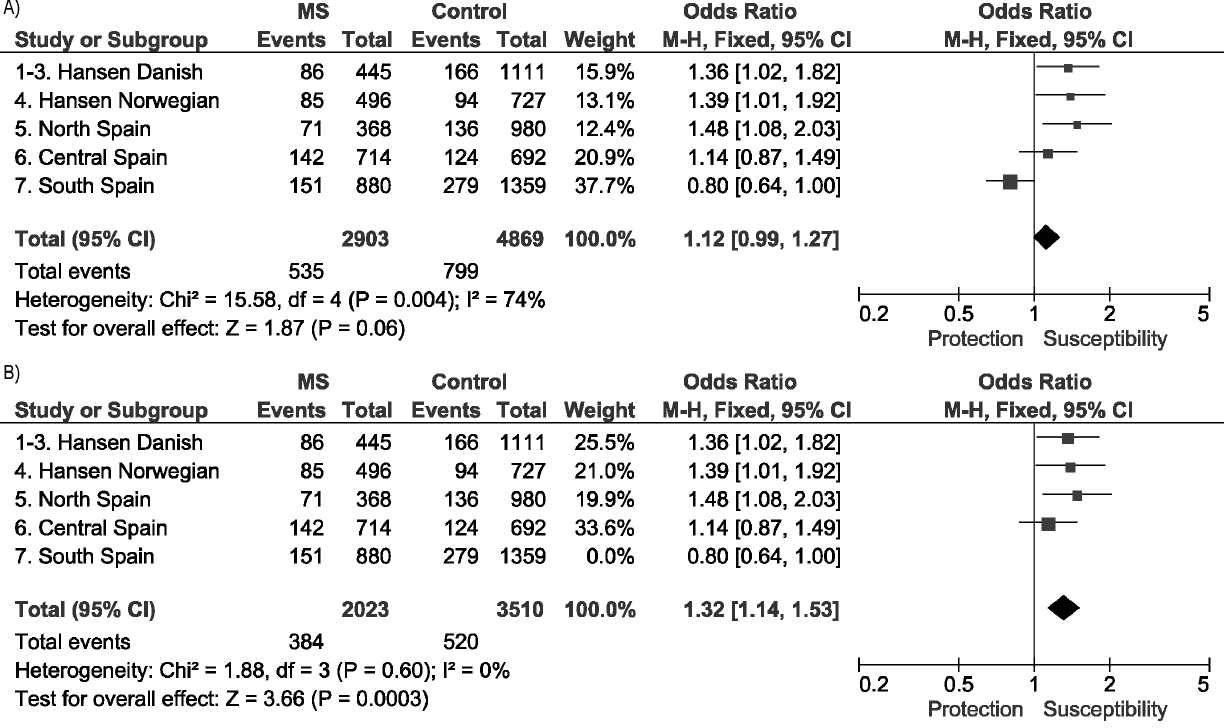
Figure 2. Meta-analysis of HERV-Fc1 association studies with bout-onset MS. Forest plot including all the available cohorts (A), and after eliminating heterogeneity by removing the Southern Spanish cohort (B).